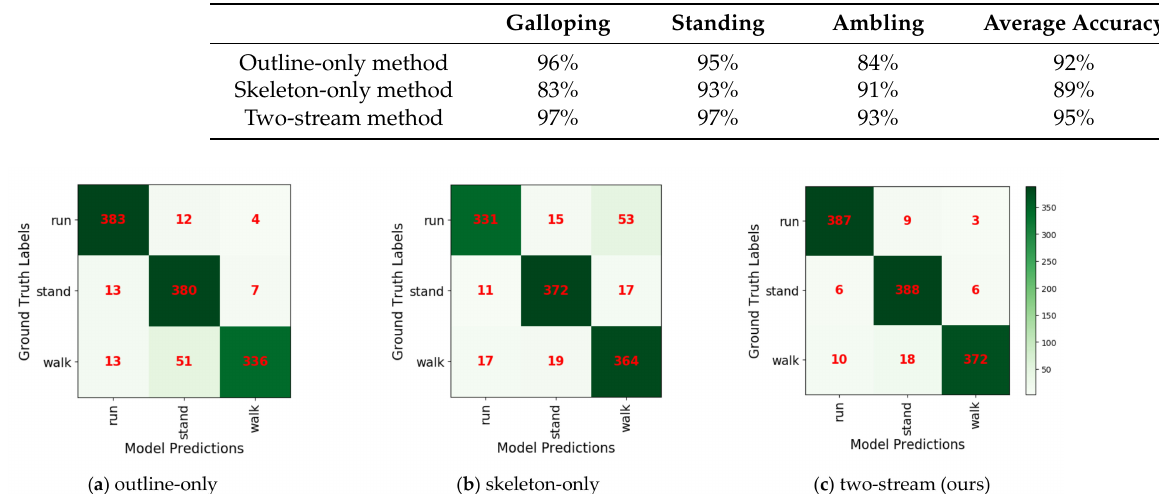
Table 6. Accuracy (%) of the ablation study: the outline-only method applies Outline Mask RCNN for target feline outline and Tiny VGG for action recognition; the skeleton-only method use LEAP to obtain target feline skeleton and Long Short-Term Memory (LSTM) for action recognition; and the two-stream method incorporates the above two methods for action recognition.